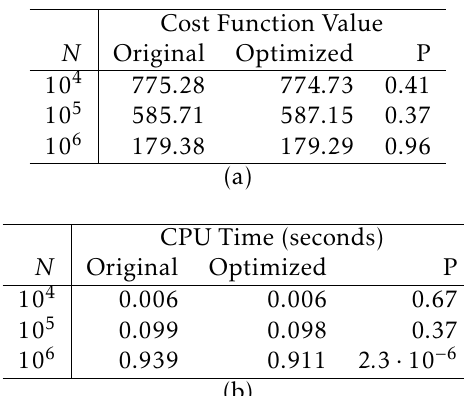
Table 3. Permutation in a Haystack: (a) optimization cost function, and (b) CPU time. Results are averages of 100 runs, and the P column shows t-test